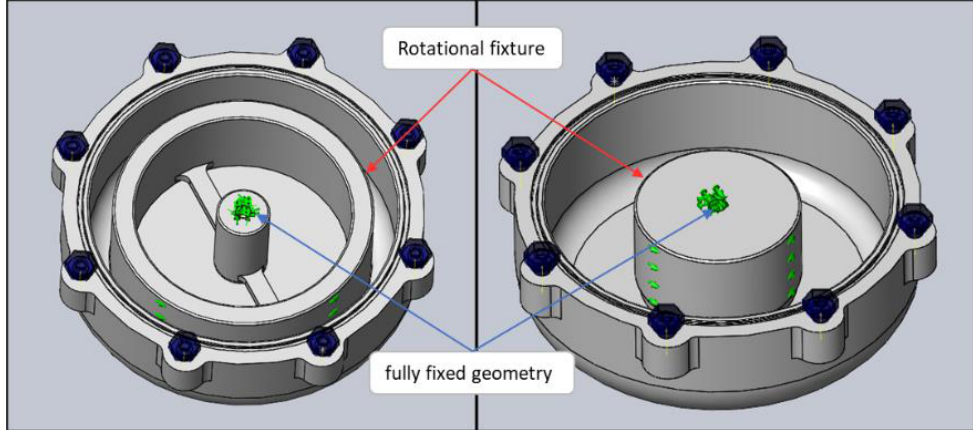
Figure 8. WCH fixture setup.